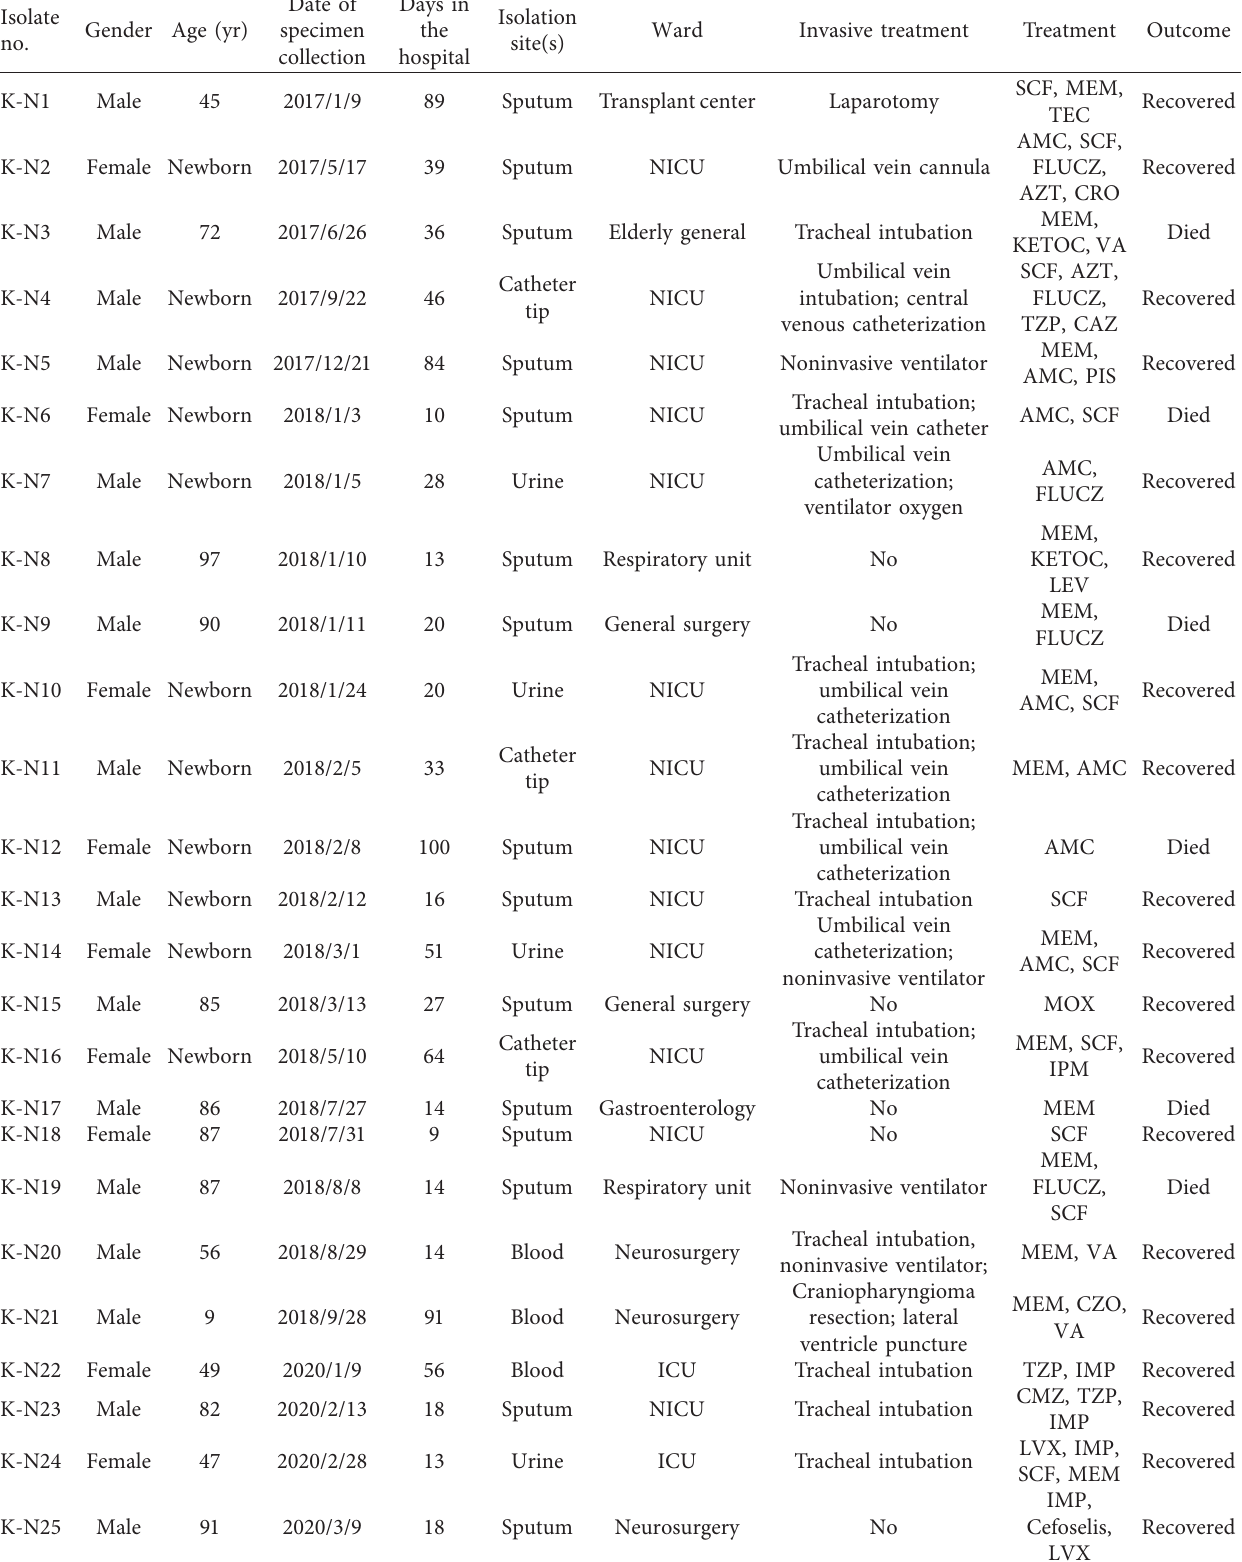
Table 1: Clinical characteristics of patients with NDM-1-positive K. pneumoniae